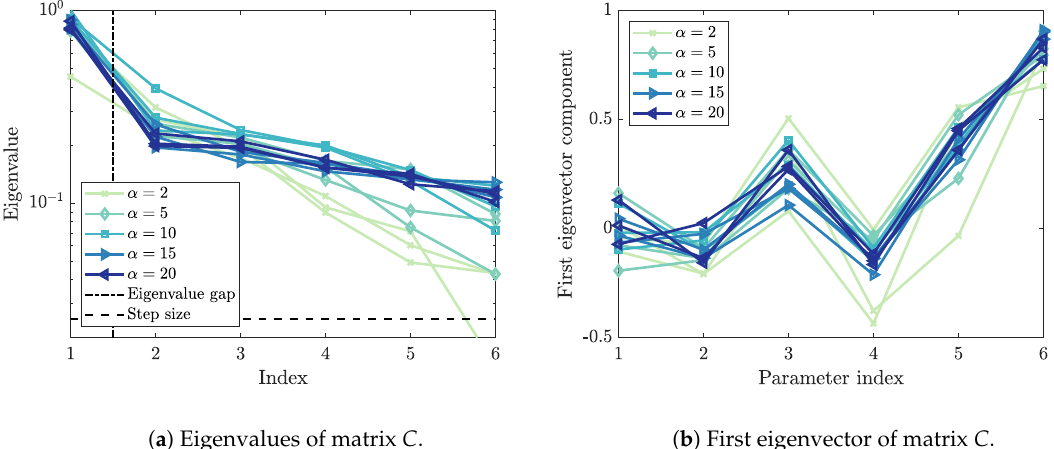
Figure 8. Eigenvalues and first eigenvector components of the matrix C . A one-dimensional subspace was identified based on the spectral gap between the first and second eigenvalue. The parameter index is mapped as follows: 1—control parameter, 2—free-flow speed mean, 3—free-flow speed standard deviation, 4—number of agents, 5—bottleneck width, 6—personal space strength. The index for the eigenvalue plot refers to the directions identified by the decomposition.